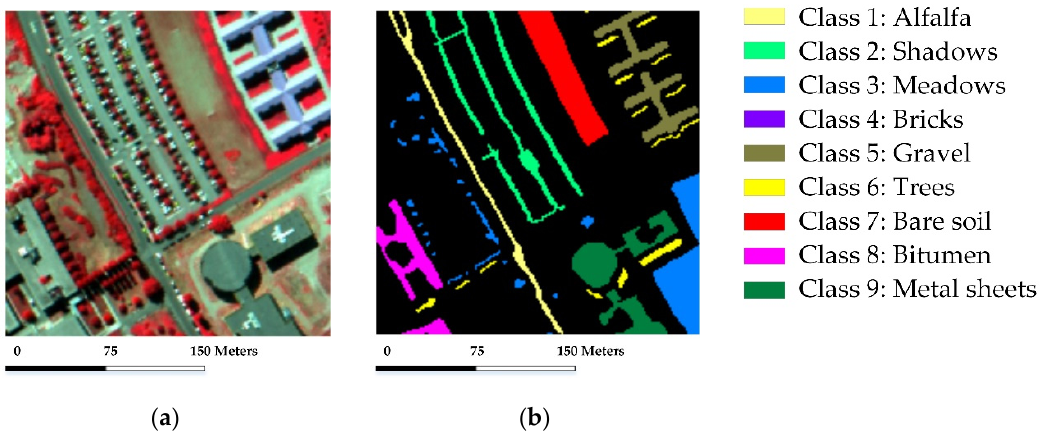
Figure 9 . The ROSIS University of Pavia scene: ( a ) false-color composite image; ( b ) reference map.